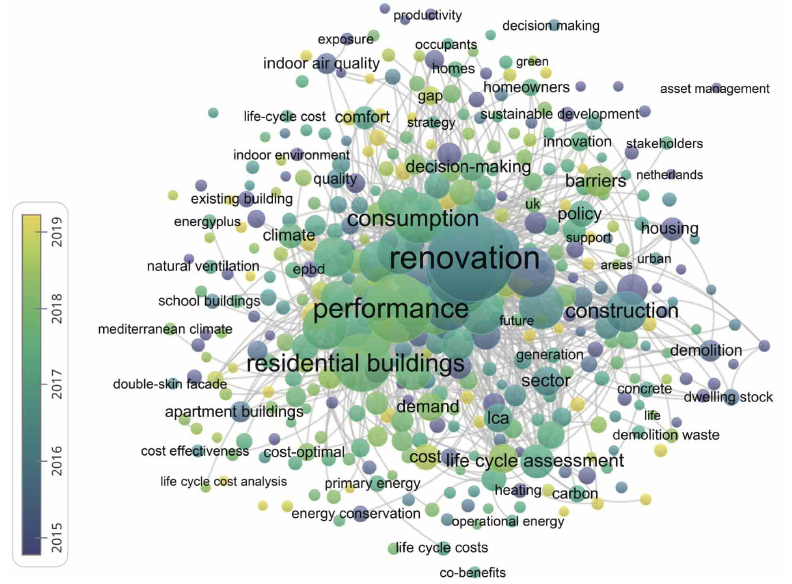
Figure 7. Co-occurrence of